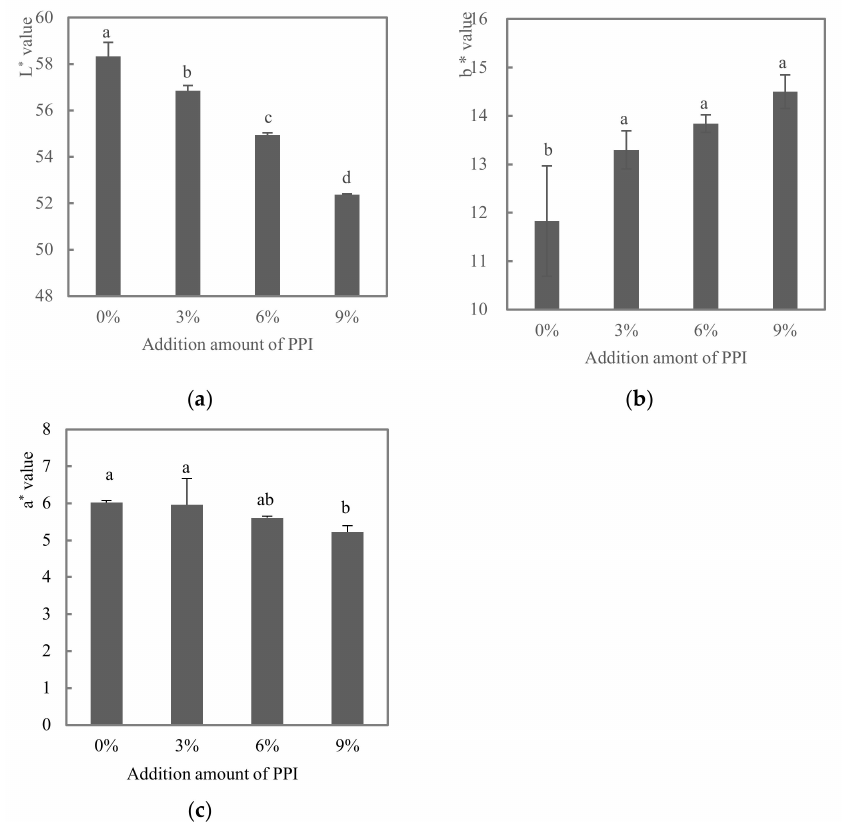
Figure 1. Effect of addition of pea protein on the L* value ( a ), b* value ( b ) and a* value ( c ) of duck meat batters. Note: 0%, 3%, 6% and 9% indicated the levels of addition of PPI to DBM. Data were expressed as the mean ± SD ( n = 3). Different letters (a–d) indicate a significant difference ( p < 0.05).